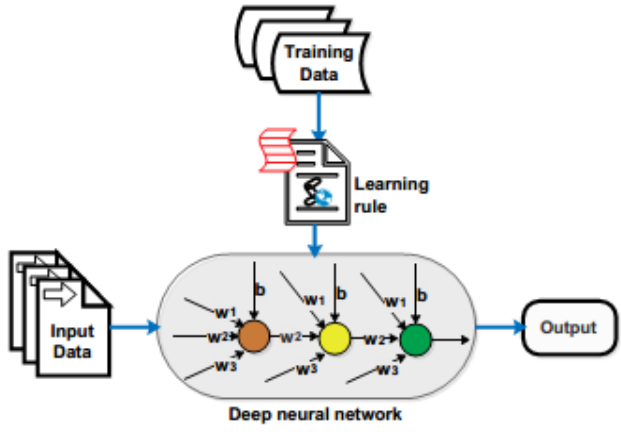
Figure 18. Deep learning process